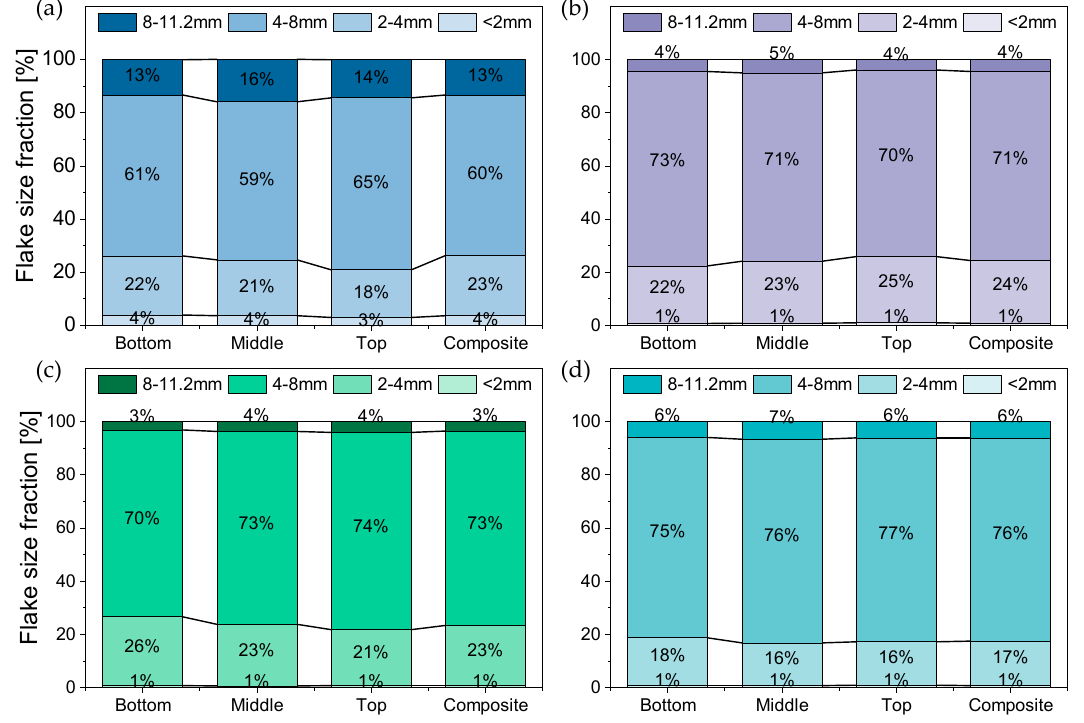
Figure 9. Flake size distribution (FSD) of the various PO feedstocks based on the evaluation by a vibratory sieve shaker tower. ( a ) PP_1, ( b ) PP_2, ( c ) PE-HD_1, ( d ) PE-HD_2.